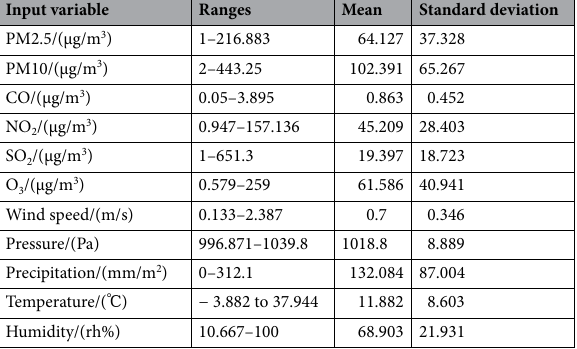
Table 1. Descriptive statistics of air quality variables from data from national control points and self-built